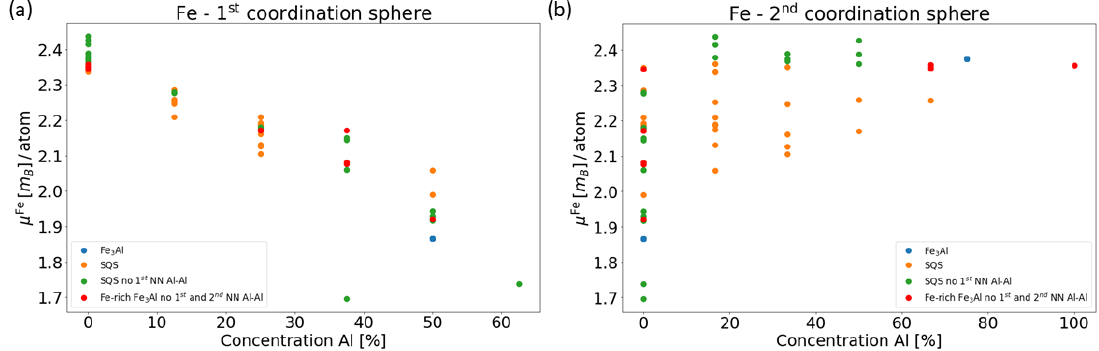
Figure 3. Dependences of local magnetic moments of Fe atoms in all studied phases (shown in Figure 1) as functions of concentration of Al atoms in the 1st ( a ) and the 2nd ( b ) coordination shell,